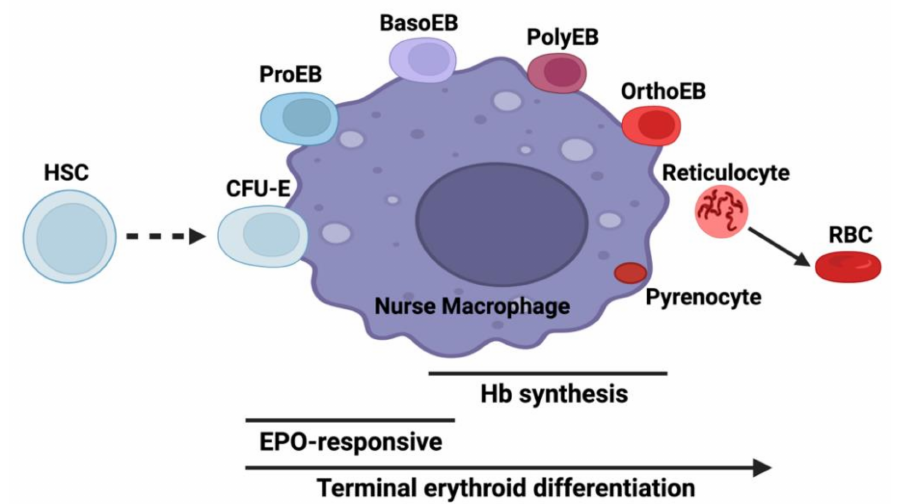
Figure 1. Erythroid differentiation in the context of the erythroblastic island niche. The diagram illus- trates interactions between developing erythroid cells and the nurse macrophage. Abbreviations are HSC: hematopoietic stem cell, CFU-E: colony-forming unit-erythroid, ProEB: proerythroblast, BasoEB: basophilic erythroblasts, PolyEB: polychromatic erythroblast, OrthoEB: orthochromatic erythroblast, RBC: red blood cell, Hb: hemoglobin, and EPO: erythropoietin. Created with